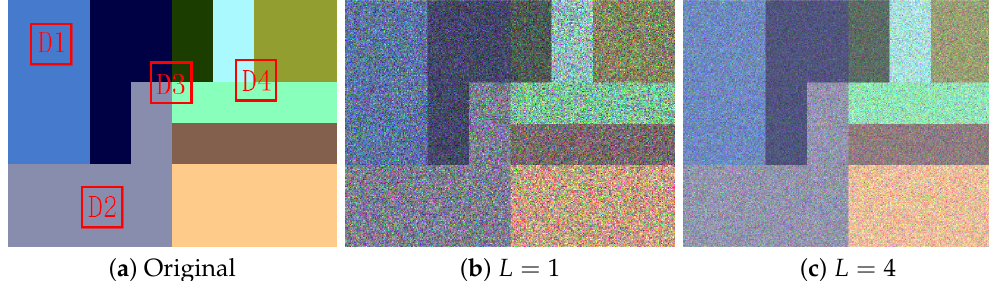
Figure 12. The simulated PolSAR images with different L : ( a – c ) original, L = 1, and L = 4,